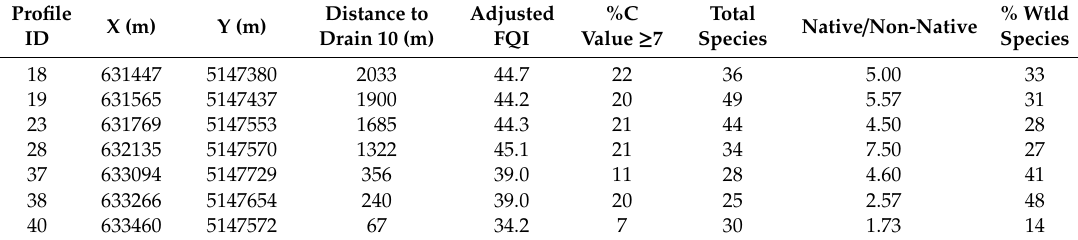
Table 2. Summary of floristic data collected along the transect profiles (Figure 3). The X and